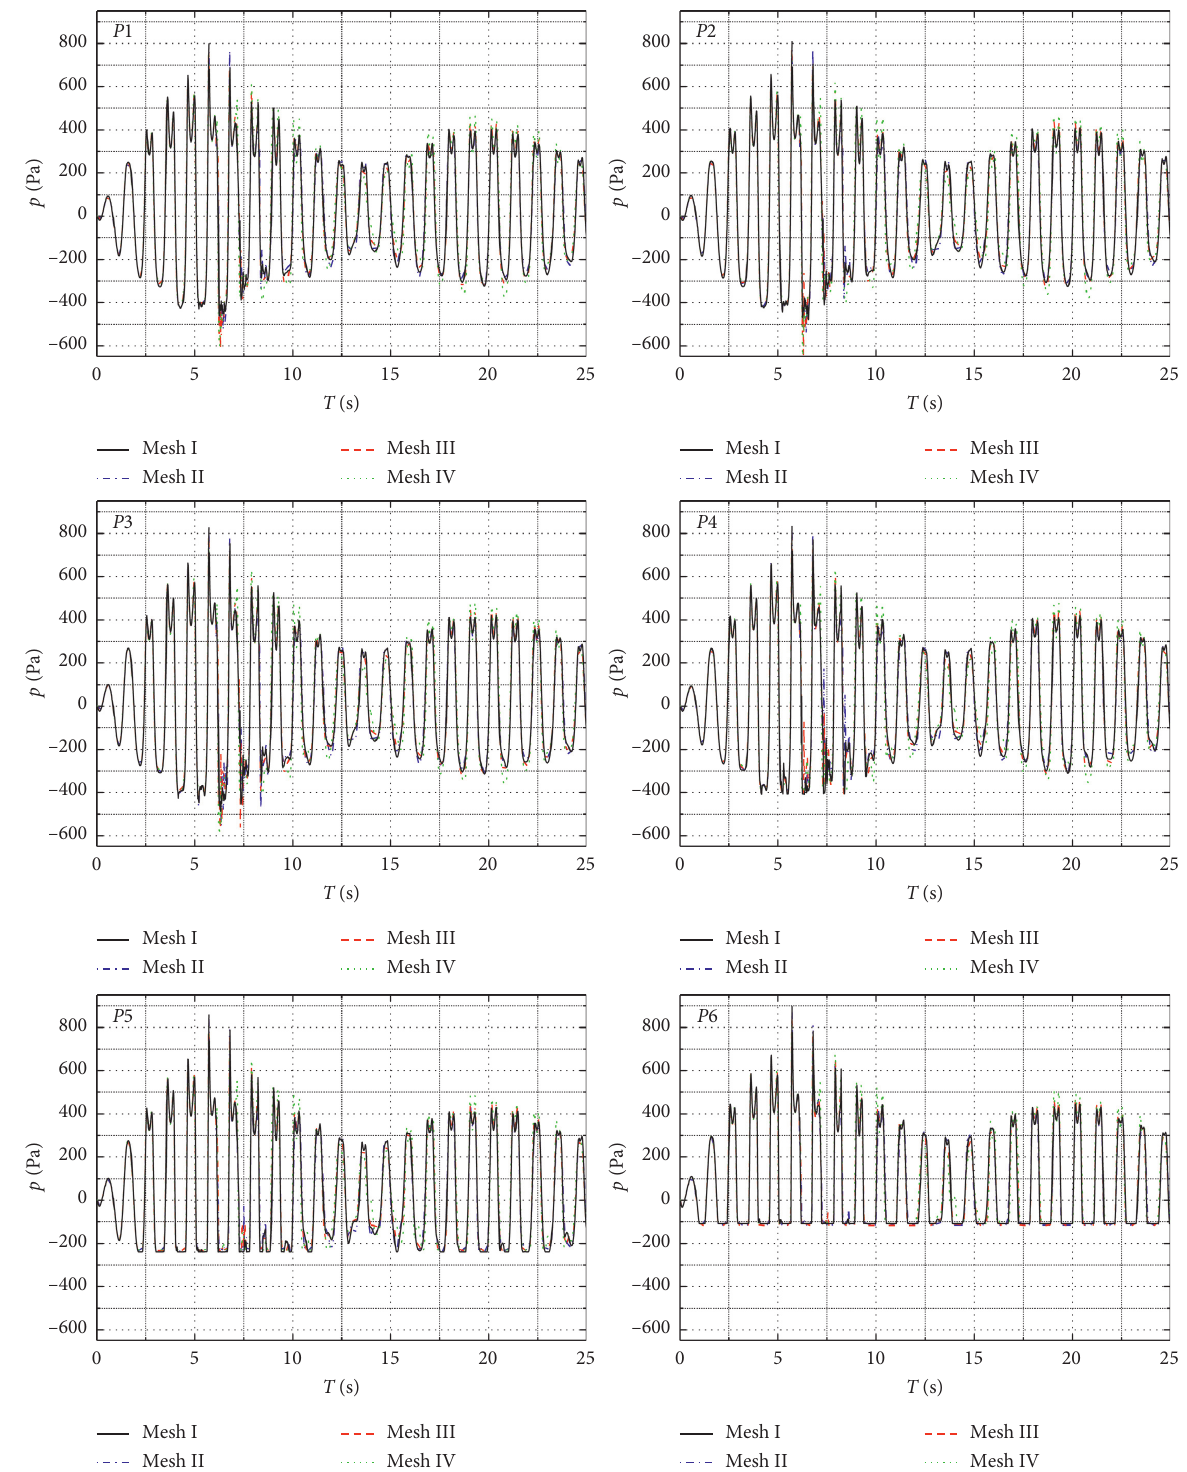
Figure 4: Time histories of pressure: mesh I (black solid), mesh II (blue dot and dash), mesh III (red dash), and mesh IV (green